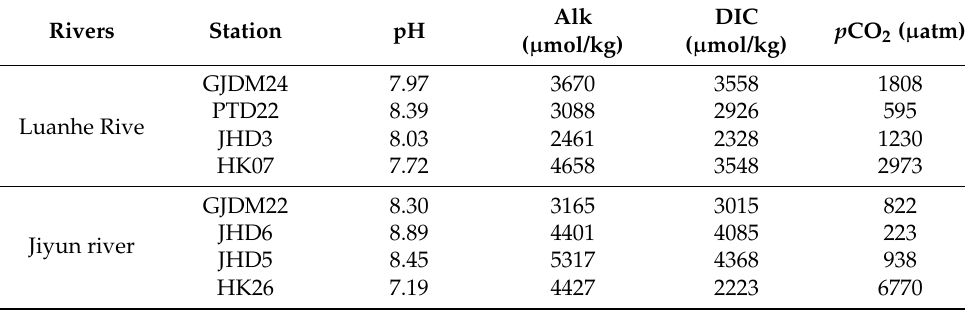
Table 3. The carbonate species in the relevant rivers flowing into the bay.